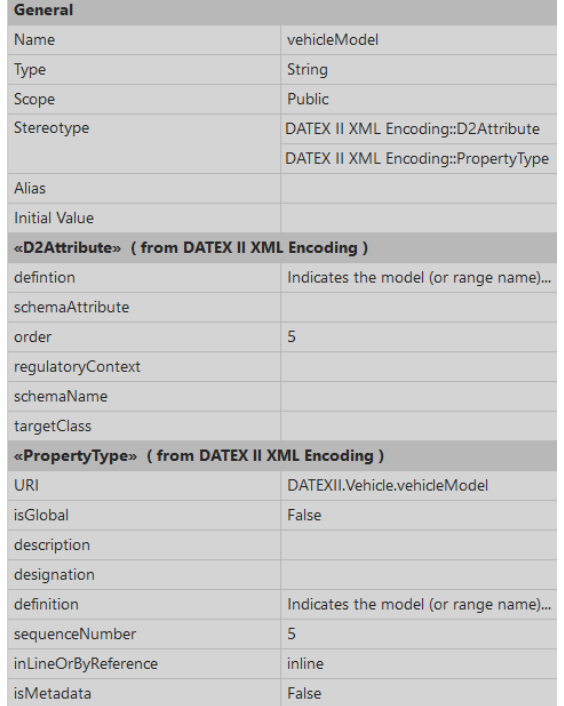
Figure 11. Example of an attribute with stereotypes from the DATEX II profiles and the